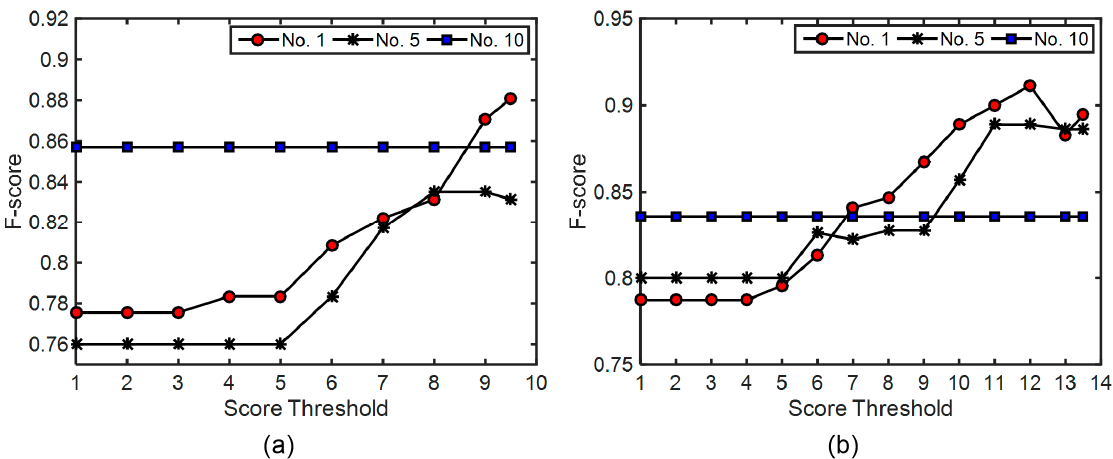
Figure 16. The effects caused by changing score threshold on test site 2: ( a ) MaxD = 1.5 m, significance level = 0.10; ( b ) MaxD = 2.0 m, significance level = 0.10. The 1st, 5th, and 10th combinations in Table 3 were applied.